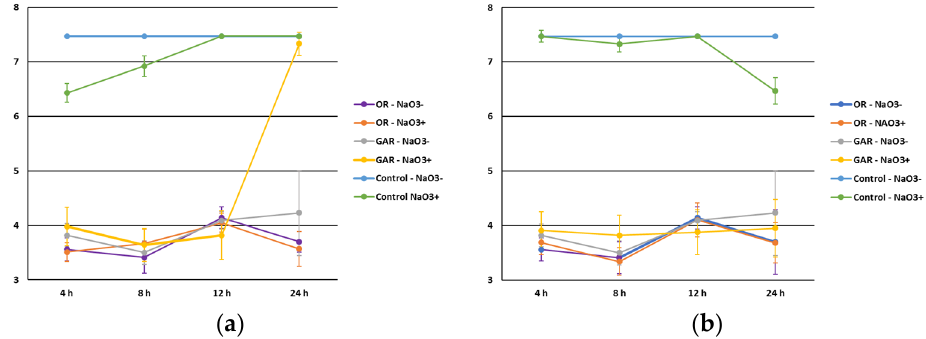
Figure 5. Influence of sodium nitrite (absence, NaNO3 − ; presence, NaNO3 + ) level on the antimicrobial effect of oregano (OR) and garlic (GAR) essential oils against Salmonella spp. ( a ) and Listeria monocytogenes ( b ).